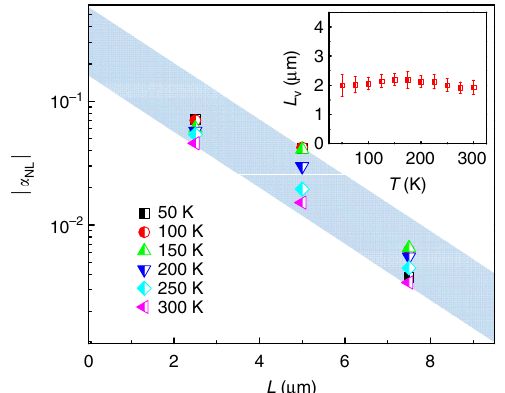
Figure 5 | Length dependence and calculated valley-relaxation length of the valley transport. The calculated | a NL | as a function of diffusion length L in sample N1. It decays exponentially with the increasing of lateral length L . The light blue background is a guide line to show the exponential decay of nonlocal resistance with channel length. The inset is the calculated valley- relaxation length L v at different temperatures. The error bars are acquired from the linear fitting to ln a NL B L . Since there is only three diffusion length in our study, we may underestimate the amount of error.